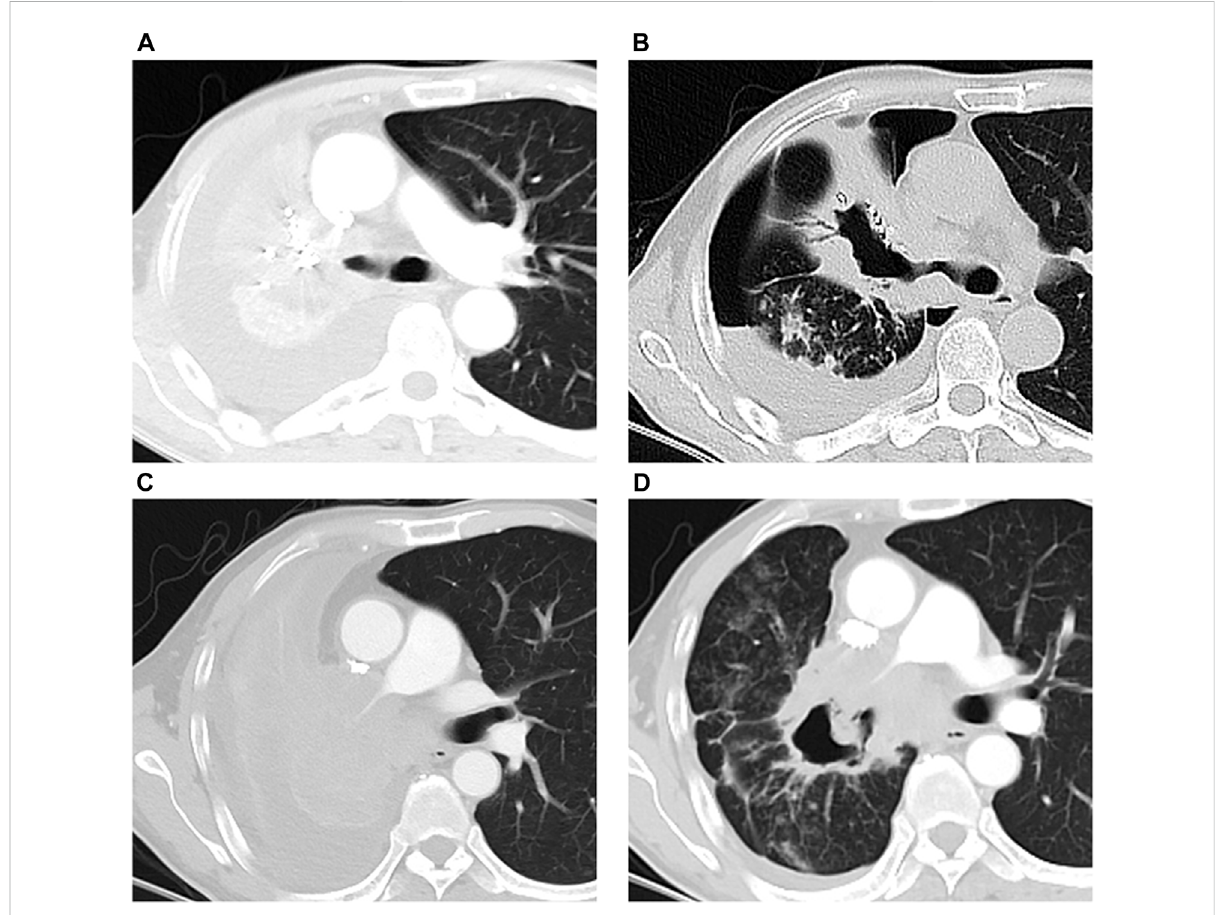
FIGURE 4 Massive hemorrhageeventsintwo patients after DEB-BACE. (A, B) Onepatientdiedof massivehemoptysisrelated asphyxia 42 days after DEB- BACE: tumor mass with central mild necrosis (A) responded to DEB-BACE, and the central cavitation within tumor mass emerged (B) 31 days after DEB-BACE; (C, D) massive hemoptysis occurred 40 days after DEB-BACE: tumor mass with obstructive atelectasis (C) responded to DEB-BACE, the central cavitation was observed (D) after DEB-BACE, and the right main pulmonary artery was invaded by the tumor